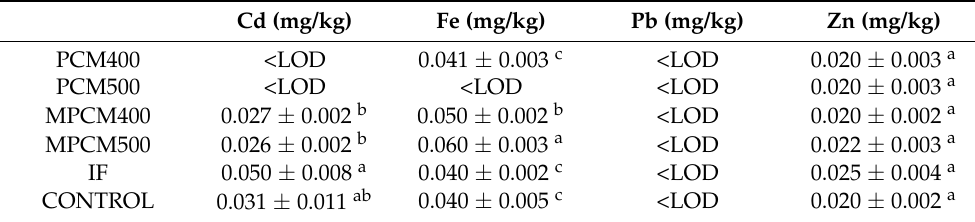
Table 4. Total concentration of Cd, Fe, Pb and Zn in rye tissues obtained from pots (mean ± SD) amended by PCM400, PCM500, MPCM400, MPCM500, inorganic fertilizer (IF) and non-amended soil